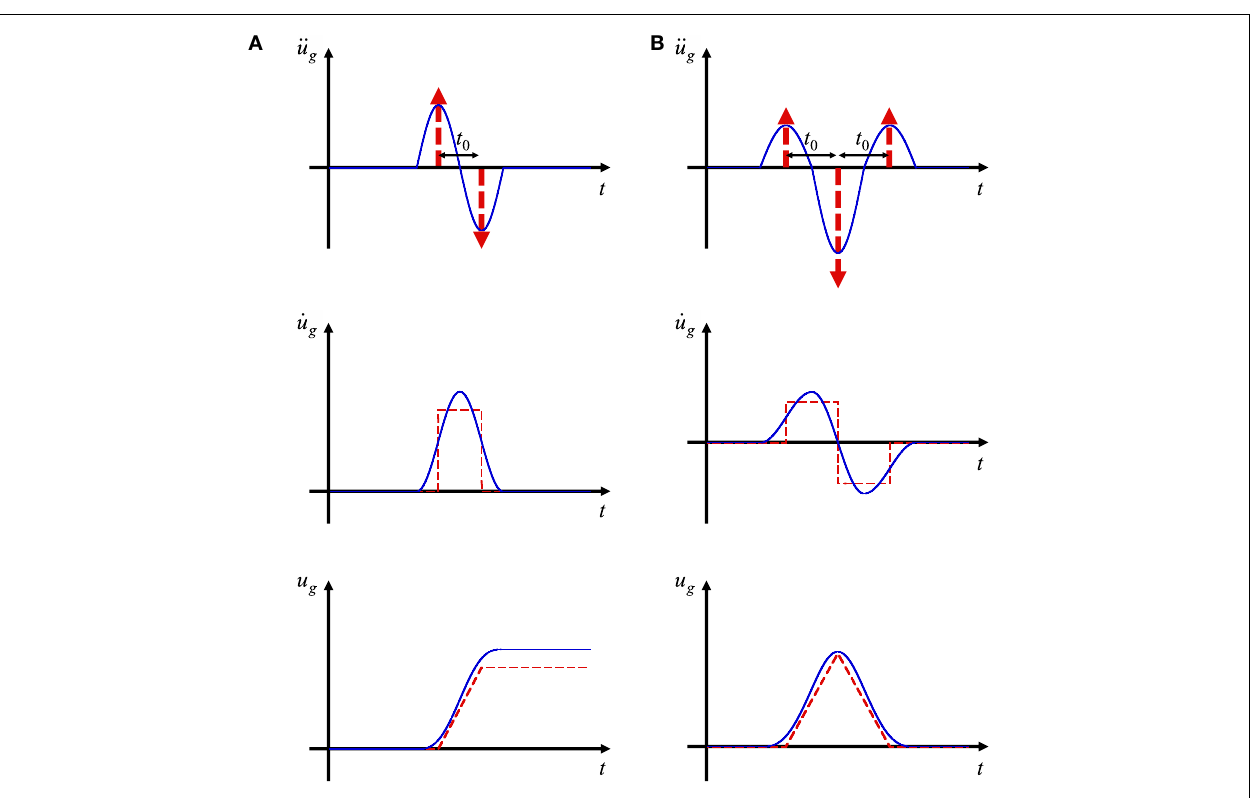
FIGURE 1 | Transformation of acceleration wavelets into a series of impulses, (A) fling-step input (blue) and double impulse (red) and (B) forward-directivity input (blue) and triple impulse (red) (Kojima and Takewaki, 2015a) .